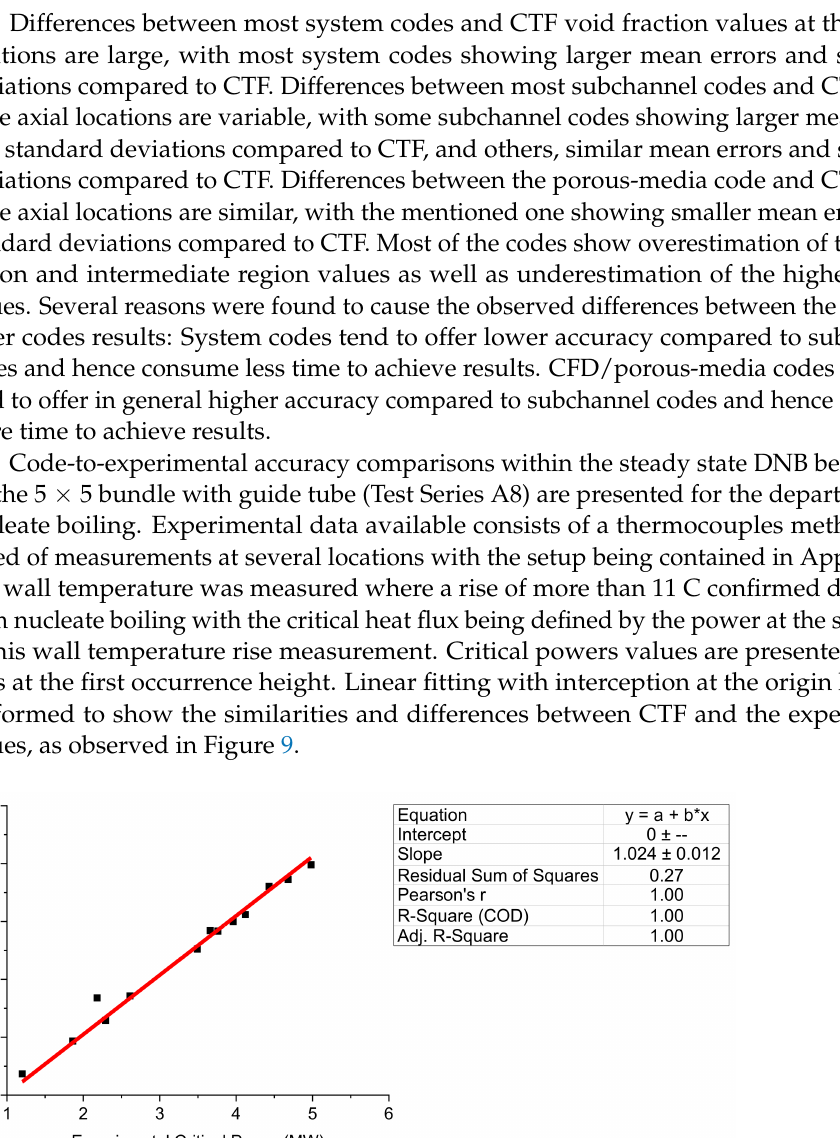
Figure 8. Codes void fraction error standard deviation.